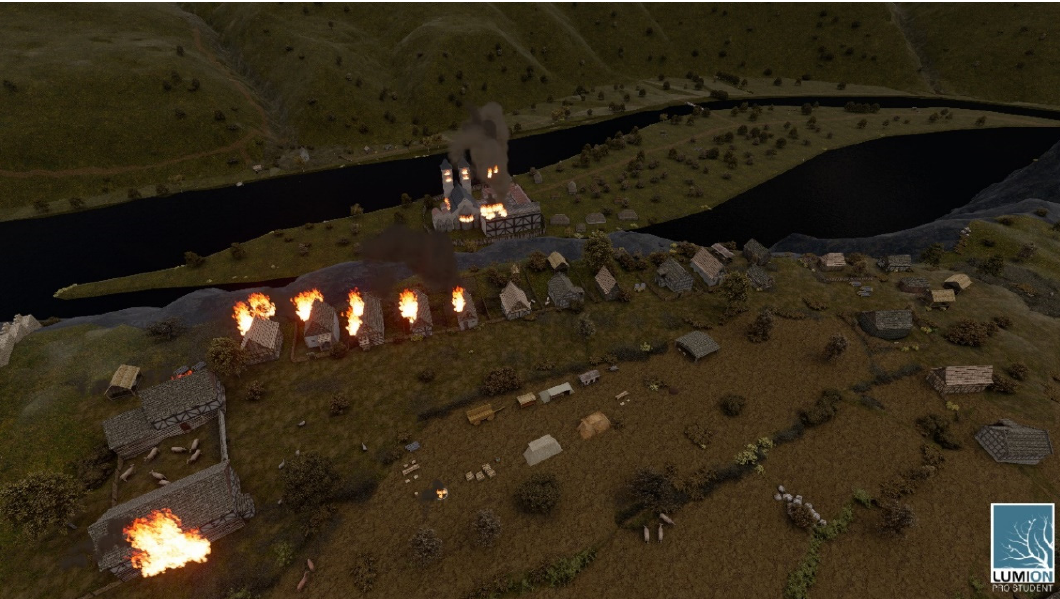
Figure A1. Illustration of the incursion of the Brandenburgers (the Romanesque era).